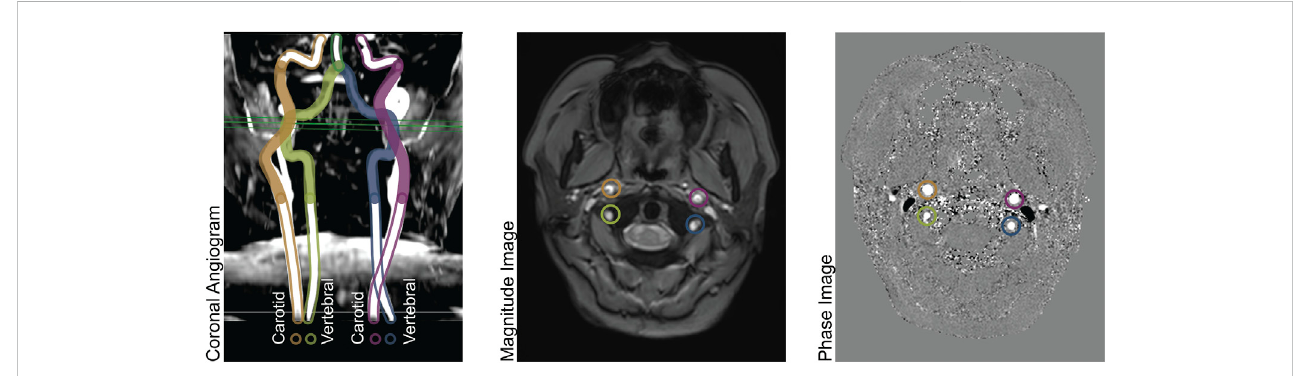
FIGURE 1 Left panel: Coronal Angiogram showing the carotid and vertebral arteries. The solid-colored portion of the vessels are above the bifurcation of the common carotid arteries, and below the level of the basilar artery. The green horizontal plane shows the location of the phase contrast slice. Center panel: a magnitude image; and right panel: a phase image, both acquired at the level indicated in the left panel.